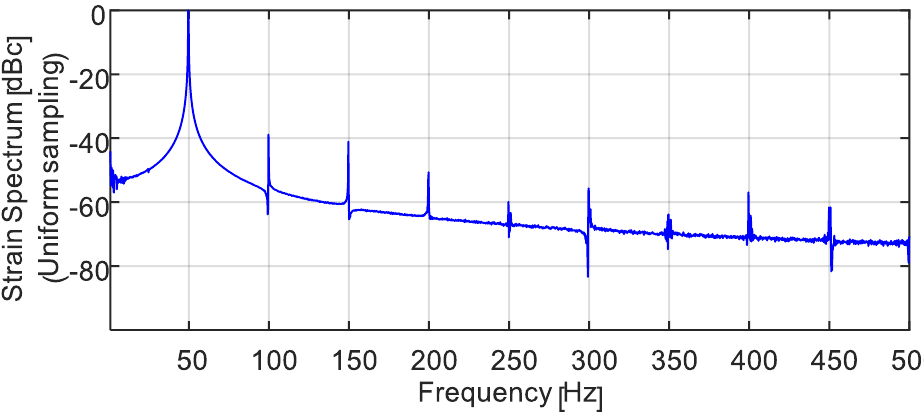
Figure 9. Strain signal spectrum at 50 Hz longitudinal vibrations, interrogated by the spectrometer- based temporally uniform interrogator. Highest harmonic (at 100 Hz) is >37 dB below the signal. The frequency-scanning Brillouin interrogation is based on an F-BOTDA setup